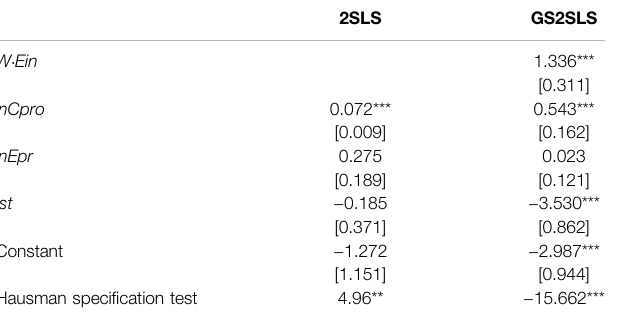
TABLE 11 | Impact mechanism of coal production on energy intensity using GS2SLS by region.